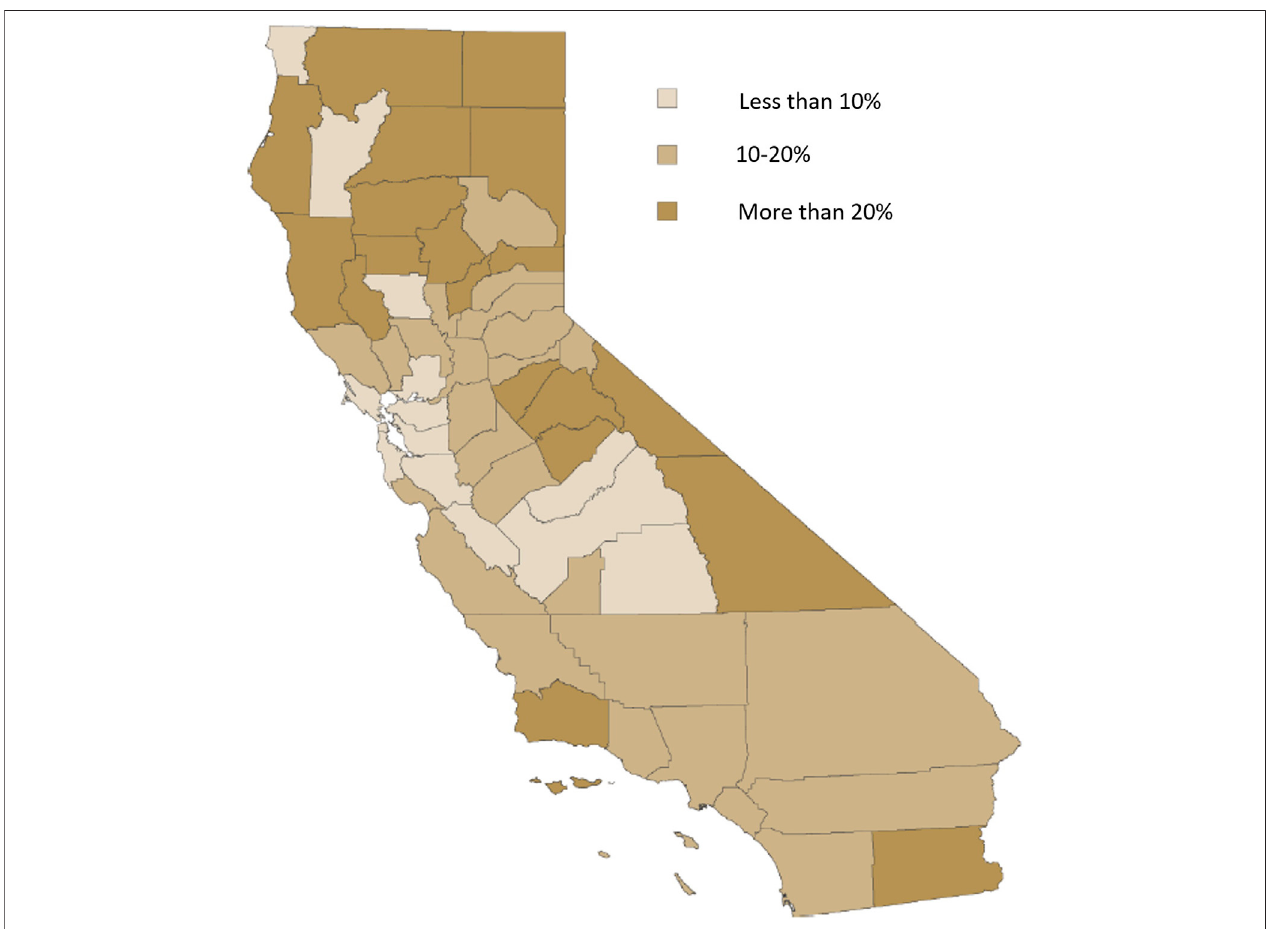
FIGURE 3 | Share of California single family households with water bills exceeding 2%, 2014. Source: Hanak et al. (2014).